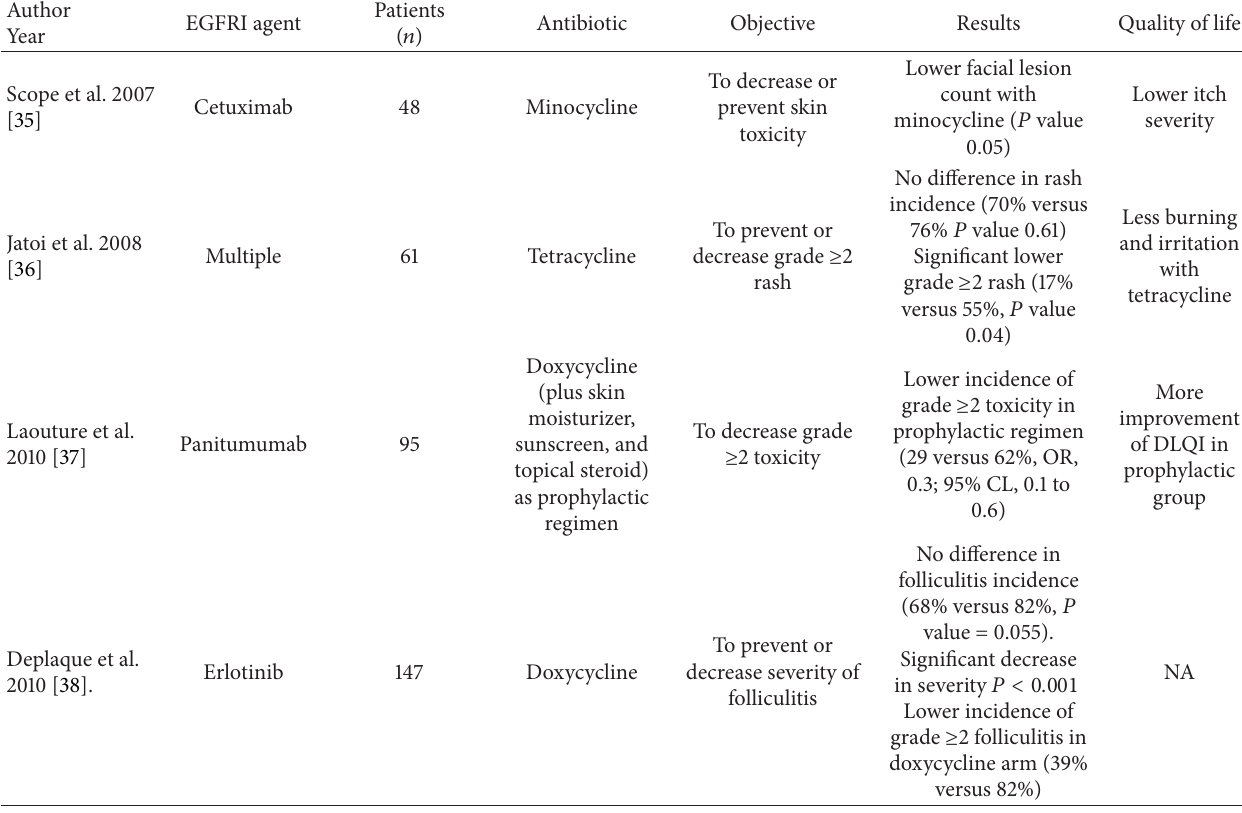
Table 1: Summery of oral antibiotic in the prevention of EGFRI-induced skin